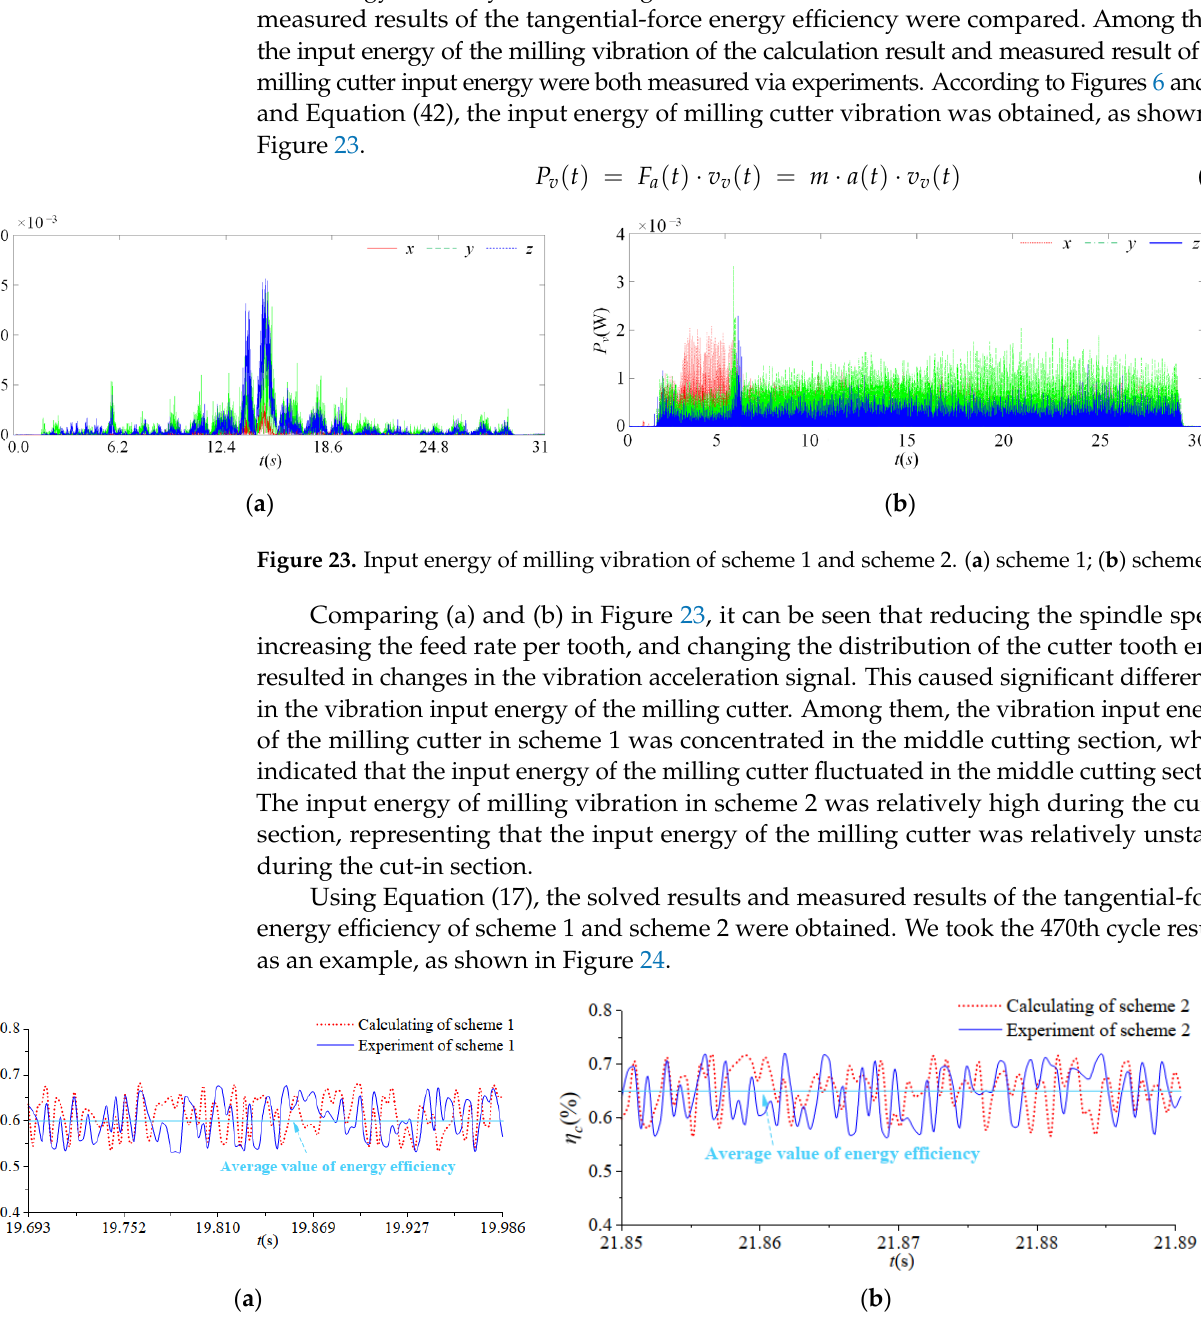
Figure 24. The solved and measured results of tangential-force energy efficiency of milling cutter. ( a ) scheme 1; ( b ) scheme 2.